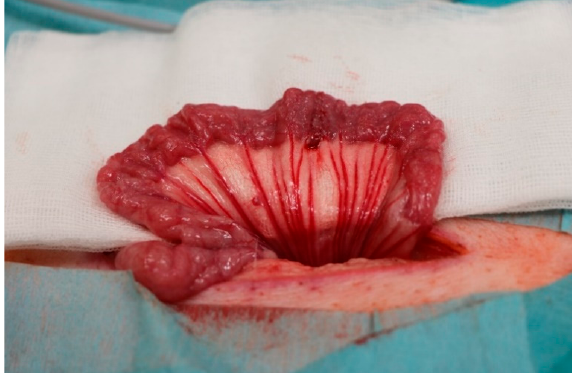
Figure 8. Operative setup after sewing of the first intestinal anastomosis. The small bowel was placed in front of the abdominal wall, and the anastomosis was sewn with running sutures. The procedure was equal for all of the used thread materials.